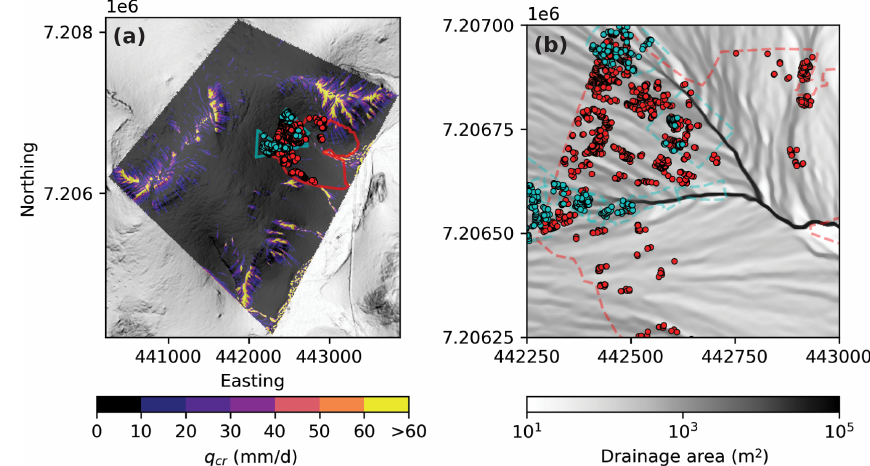
Figure 7. (a) Map of entire SHALSTAB model domain with color contours demonstrating critical rainfall ( q cr ) necessary to instigate failure. Note most of the model domain is predicted to be unconditionally unstable given our parameters (see text). UAS survey area and mapped failures in 2018 (red) and 2019 (cyan) shown. Background slopeshade generated from ArcticDEM as described in the text. (b) Drainage area versus mapped failures. Dashed lines are UAS survey areas as in Fig. 2a.